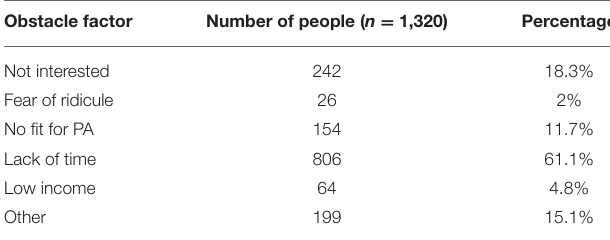
TABLE 5 | Barriers to participation in physical activities by rural